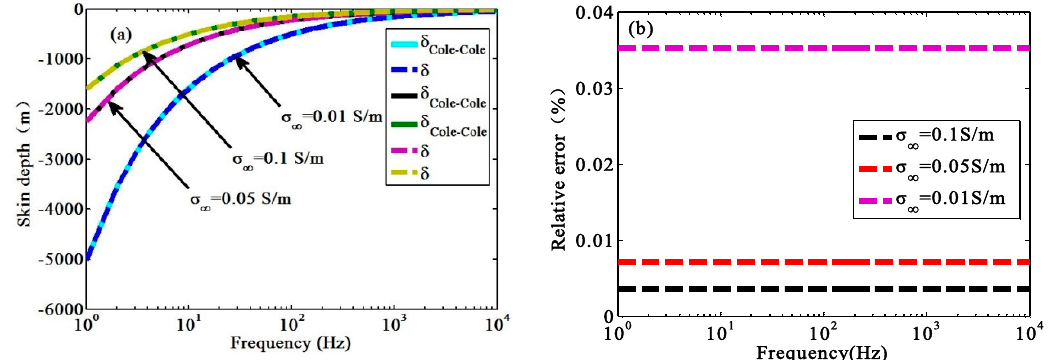
Figure 1. The η = 0 generalized skin depth of polarized media (( a ) calculation of depth, ( b ) relative error).